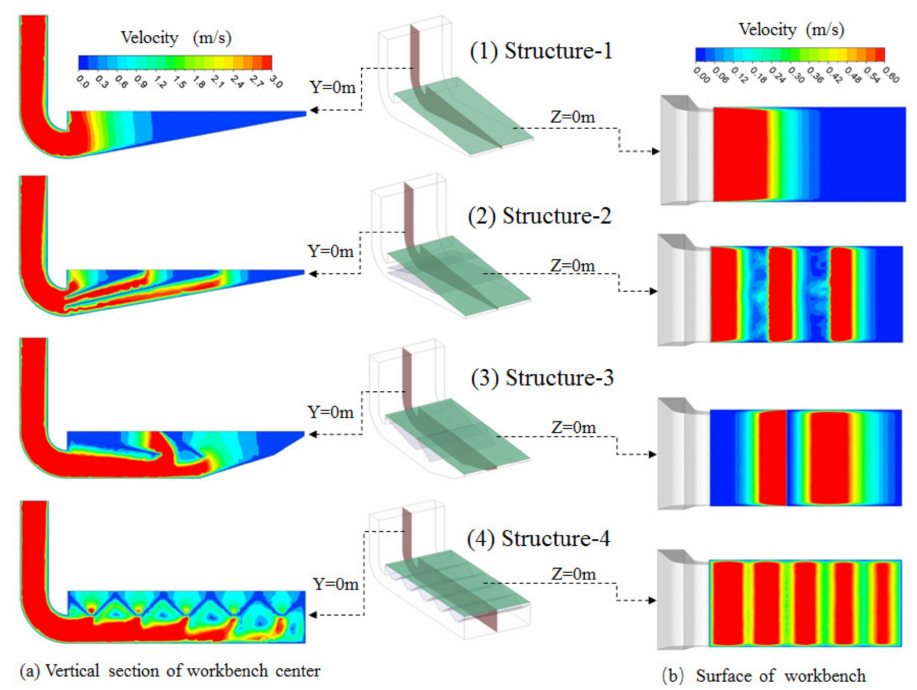
Figure 8. Velocity contour maps for differently structured workbenches. ( a ) Velocity contour map of a vertical section at the center of the workbench; ( b ) velocity contour map of the workbench